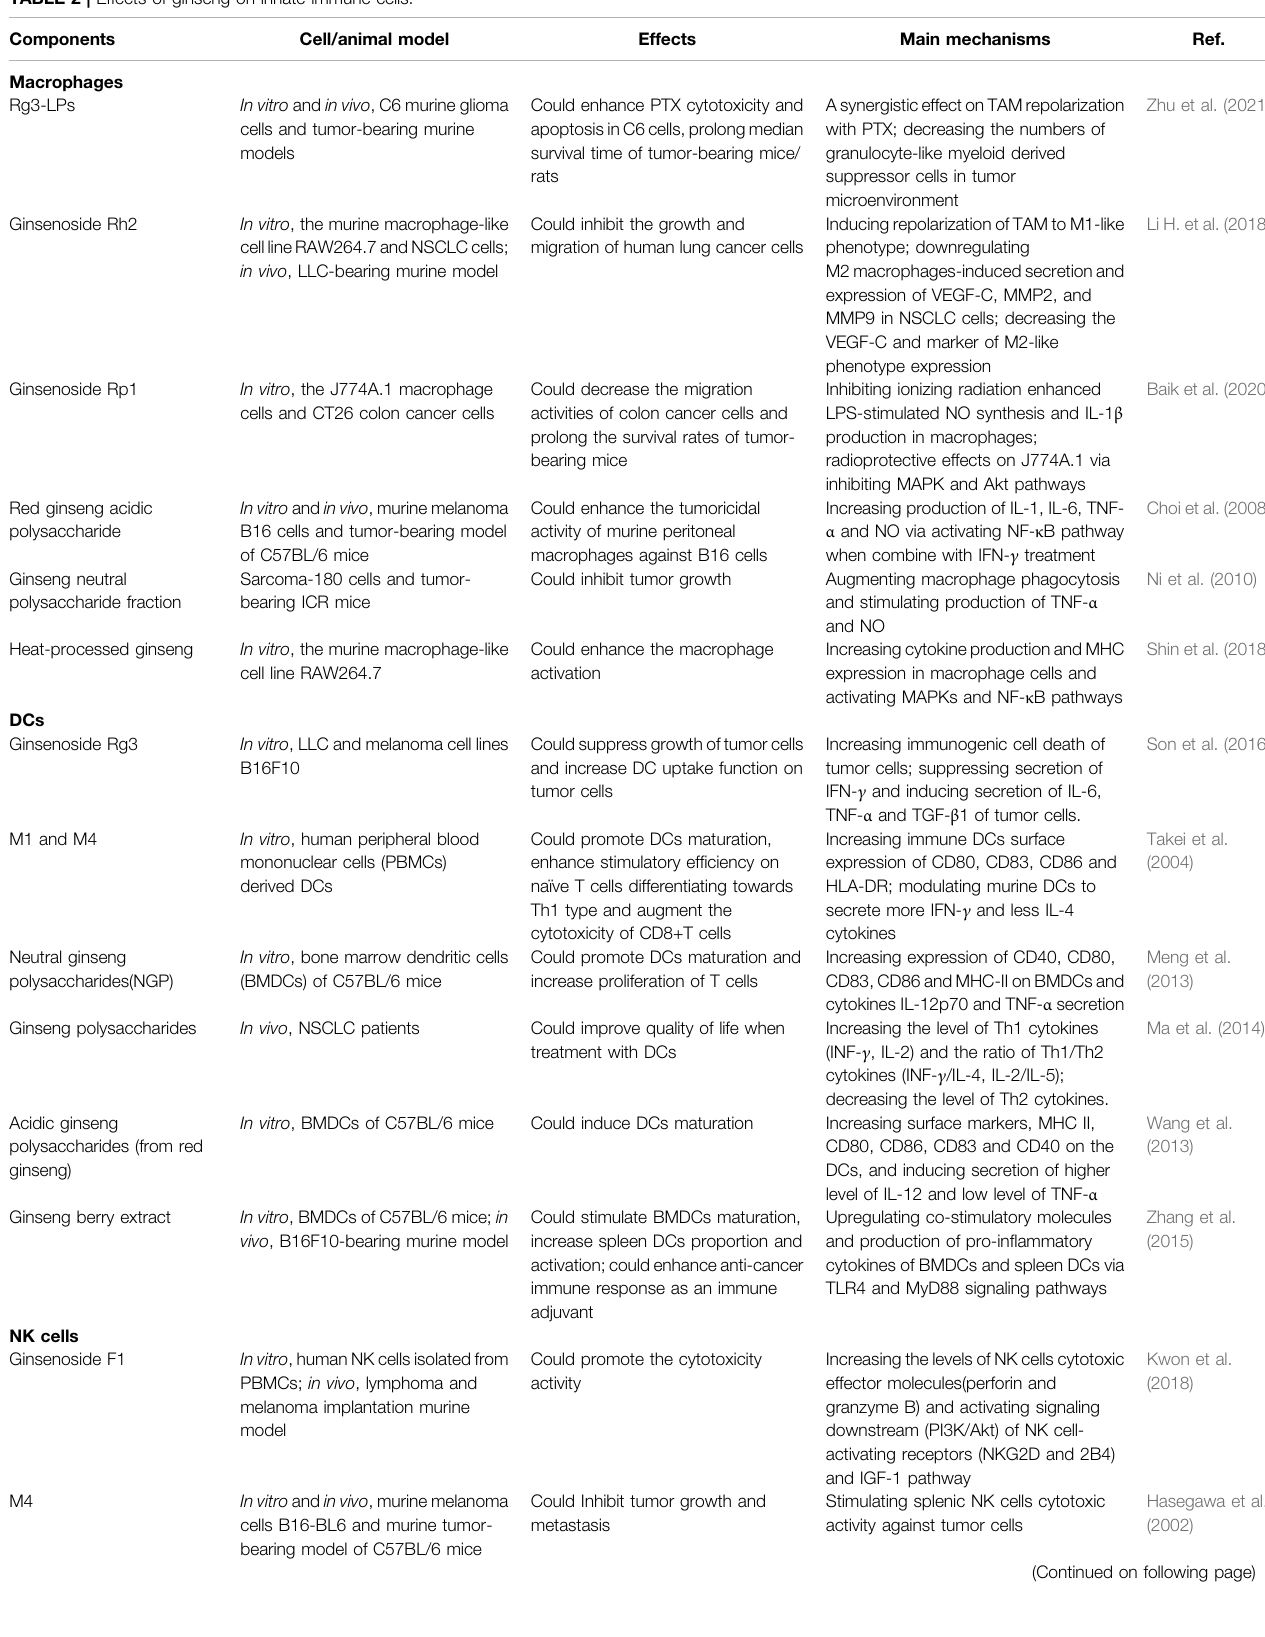
TABLE 2 | Effects of ginseng on innate immune